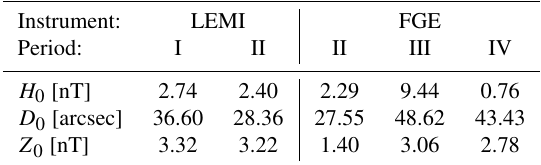
Table 1. Variances of the base values for the LEMI sensor and the FGE sensor. The variances have been calculated for the horizontal field component ( H ), declination ( D ), and the vertical field compo- nent ( Z ) for four different